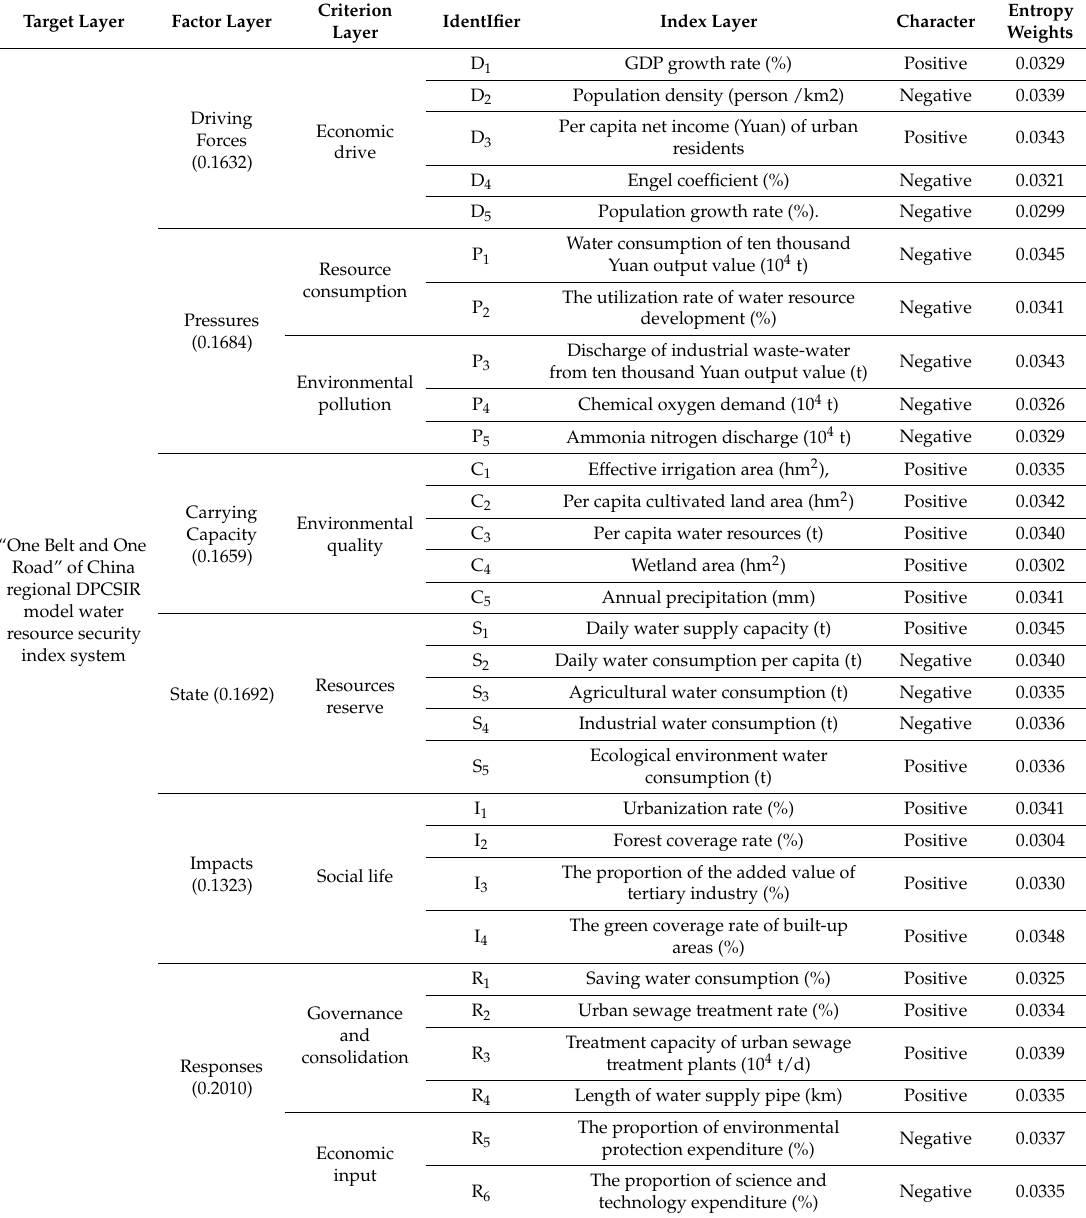
Table 3. The weights of indicators for the water assessment